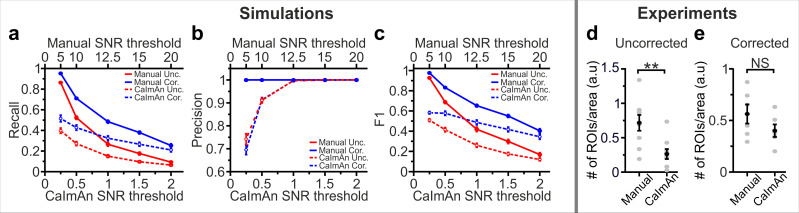
Manual vs. automated segmentation in simulated and experimental t-series.(a), Recall values for the segmentation of simulated data in t-series obtained in uncorrected (red) and corrected (blue) microendoscopes for the manual (continuous line) and automated CaImAn (Giovannucci et al., 2019, dashed line) segmentation approaches (n = 9 simulations). (b) Same as in (a) for precision. (c) Same as in (a) for the F1 score. (d) Spatial density of ROIs identified in in vivo experiments using manual and automated segmentations for uncorrected microendoscopes. n = 9 FOVs from three animals. Paired Wilcoxon signed-rank test, p=4E-3. (e) Same as in (d) for corrected microendoscopes. n = 6 FOVs from three animals. Paired Wilcoxon signed-rank test, p=0.11.Figure 4—figure supplement 1—source data 1.Comparison of manual vs automated segmentation methods in simulated and experimental data.